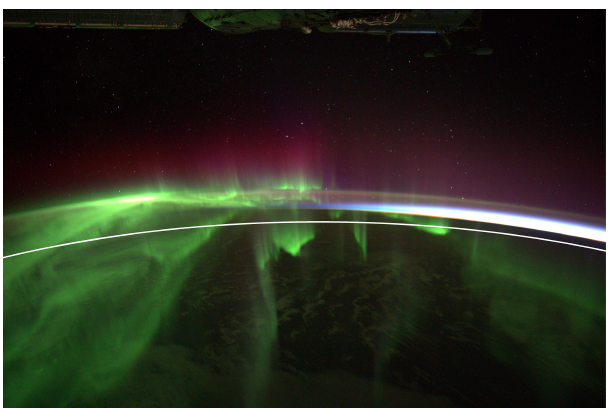
Figure 8. An image with the expected position of the Earth’s hori- zon overplotted.